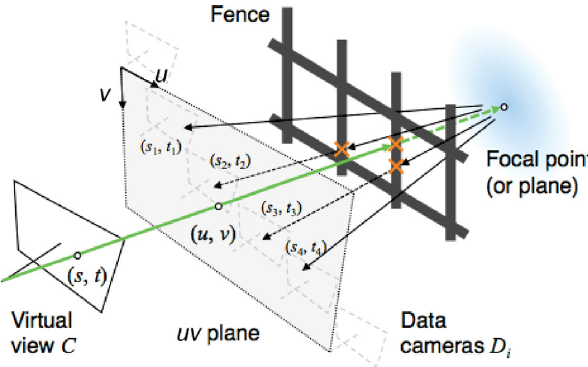
Fig. 5 Light field rendering